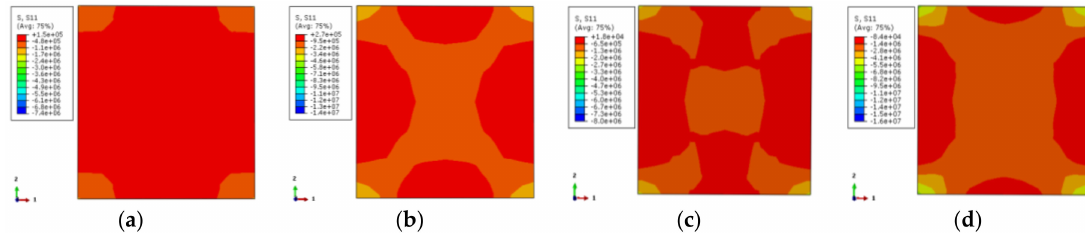
Figure 14. The lateral stress distribution of concrete ( a ) DS-200-0-0.75; ( b ) DS-200-0-1; ( c ) DS-200-0.75; ( d )